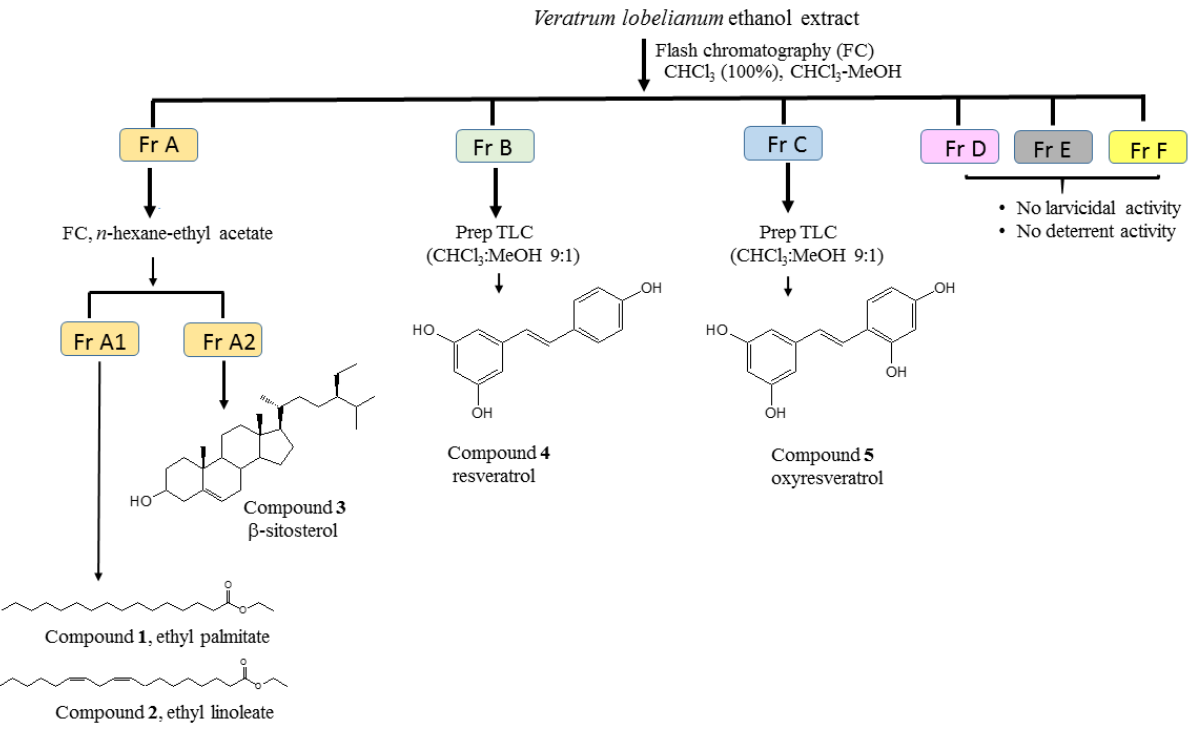
Figure 2: Schematic procedure of bioassay-guided isolation of active components from Veratrum lobelianum